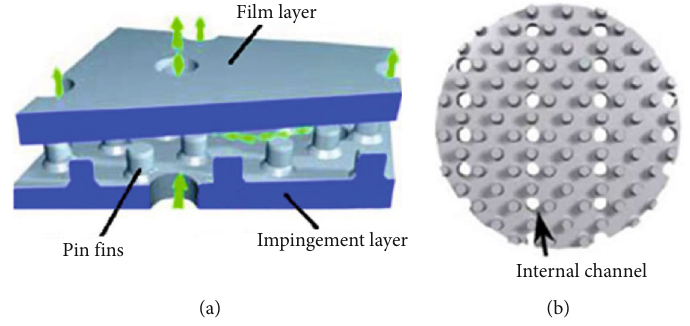
Figure 1: Schematic of laminated cooling